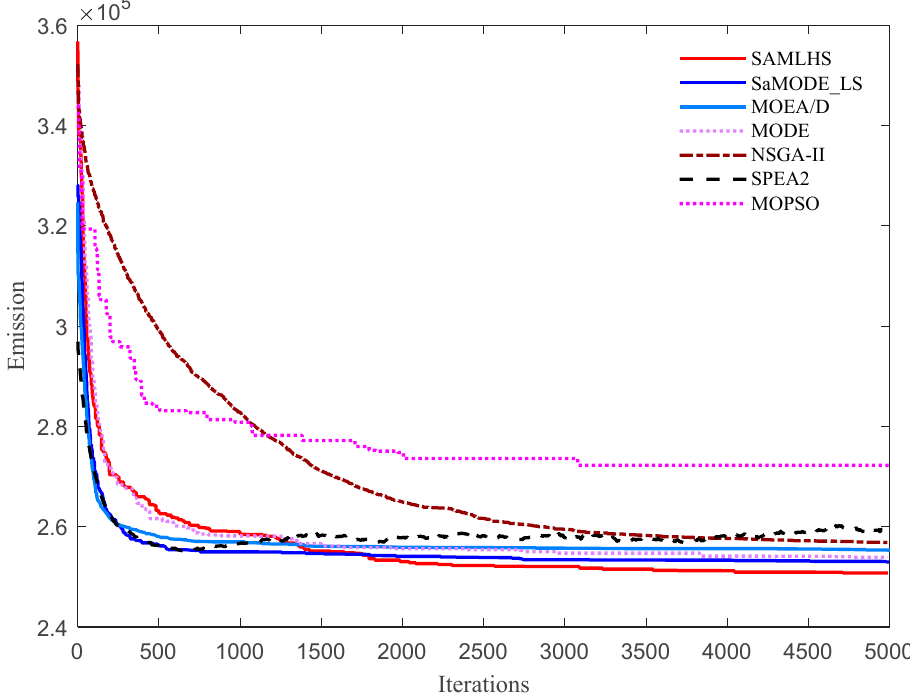
Figure 3. The convergence of emission for different algorithms.